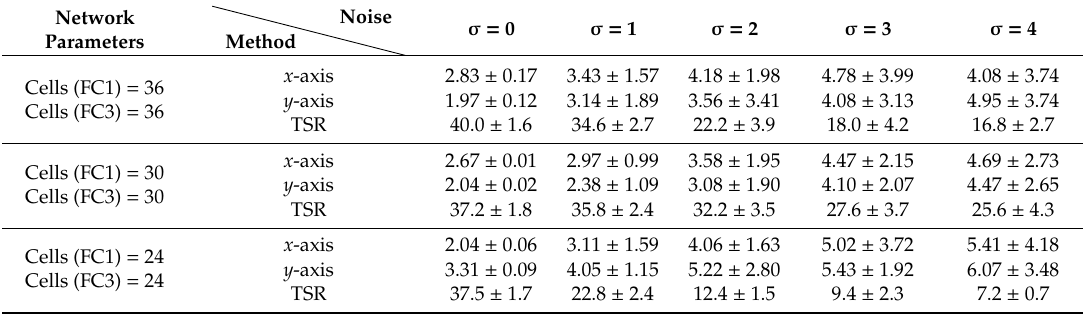
Table A5. Tracking results of UAV in the sensor noise environment with di ff erent neural parameters. The RMSE and TSR are shown in this